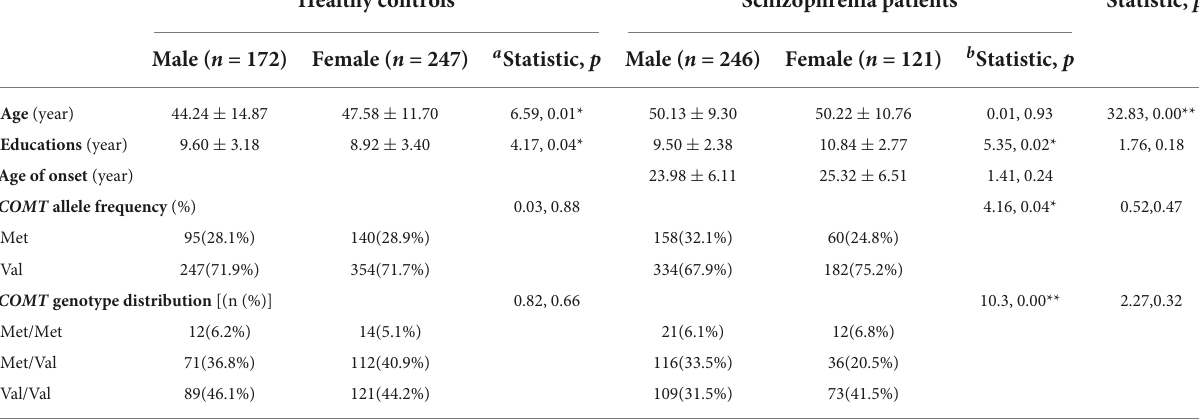
TABLE 1 Sample characteristics of healthy controls and chronic schizophrenia patients.